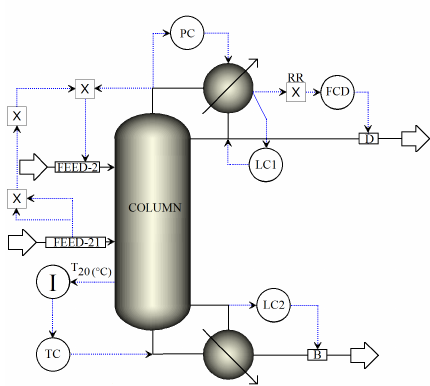
Figure 9. Structure RR with single tray temperature